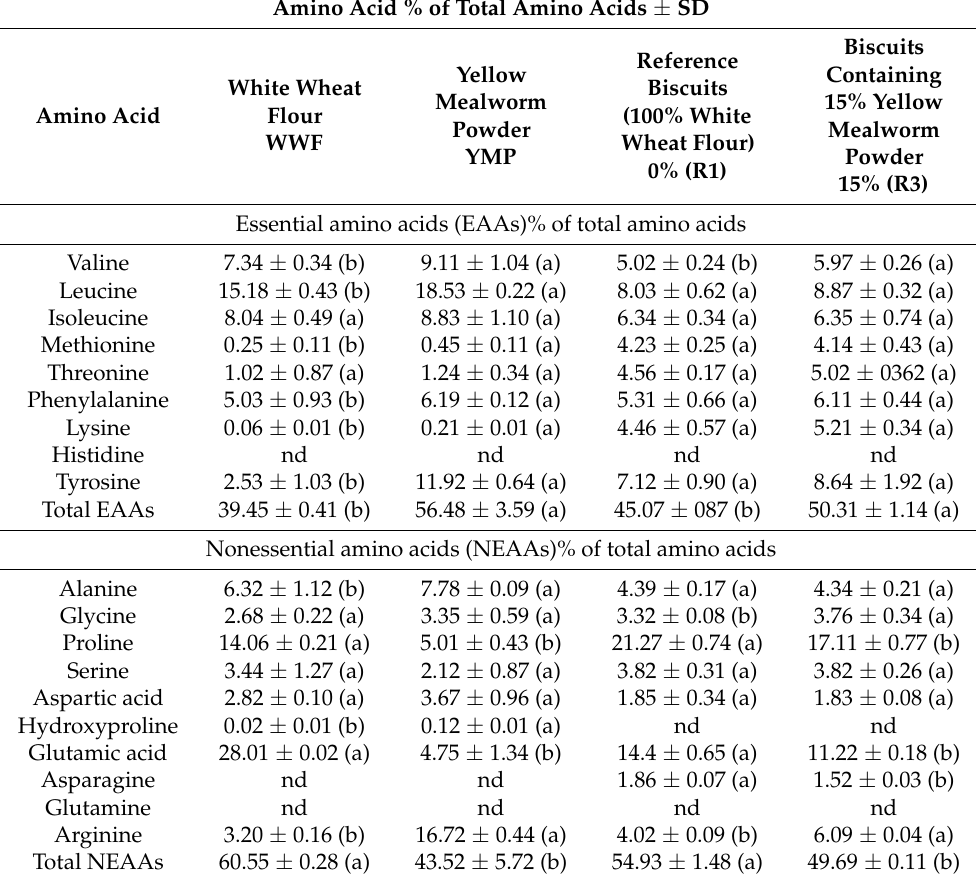
Table 4. Amino acids profiles in white wheat flour (WWF), yellow mealworm powder (YMP), and selected